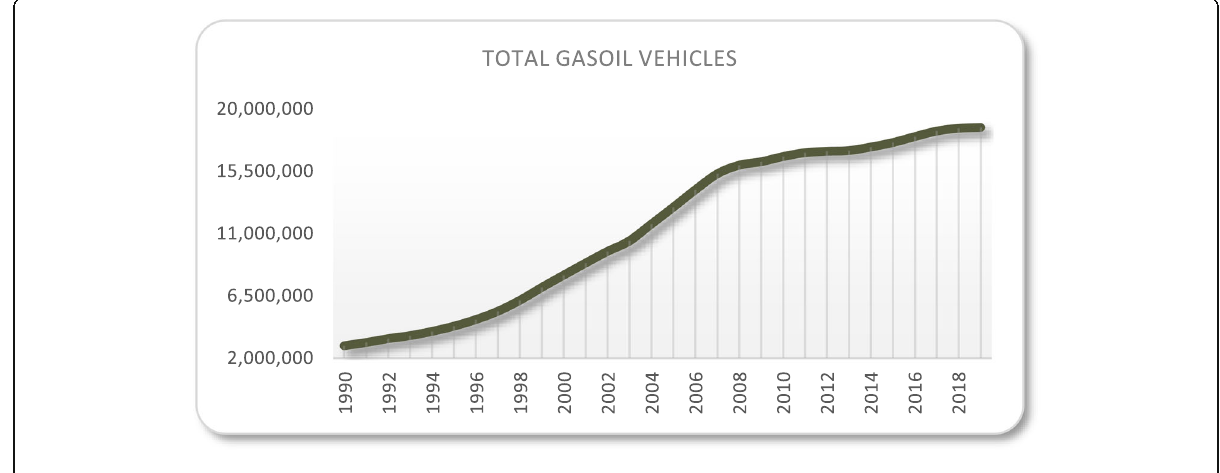
Fig. 19 Total gasoil vehicles fleet in Spain (2019